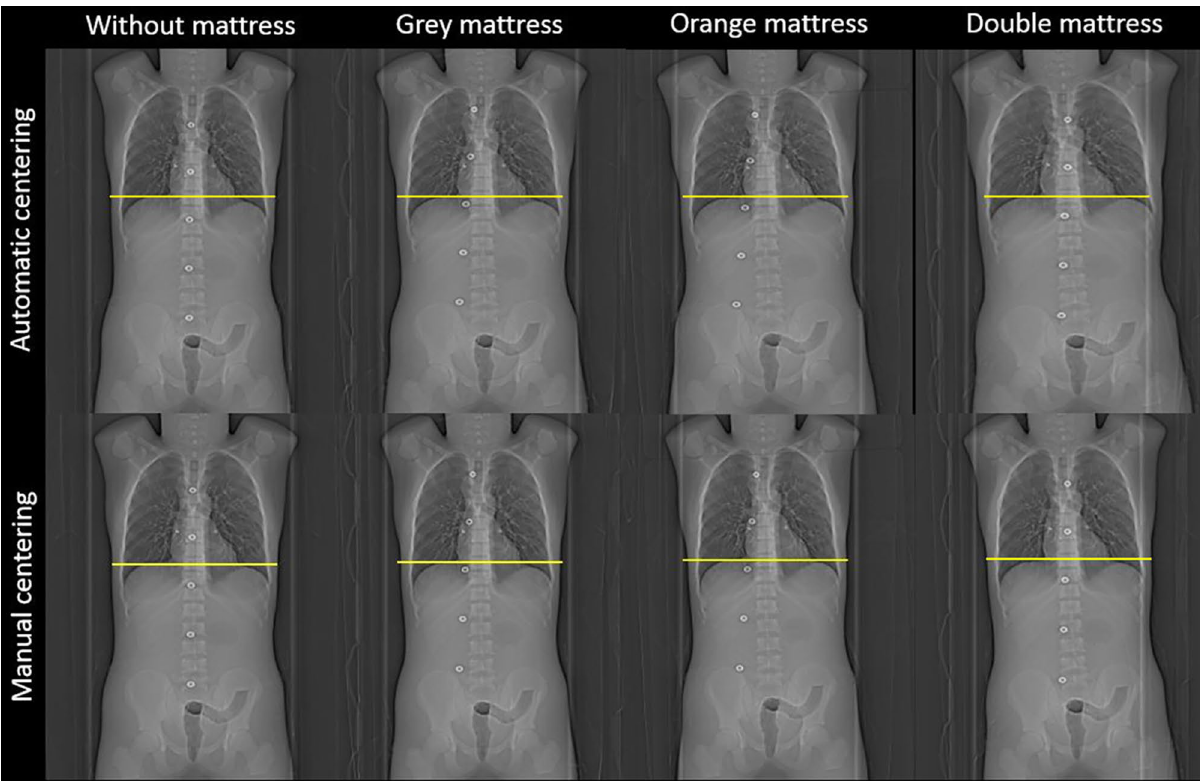
Figure 2. Topographic images obtained after centering the phantom automatically with the 3D camera then manually without and with the three additional mattresses. The yellow line corresponds to the phantom width from the image acquisition without an additional